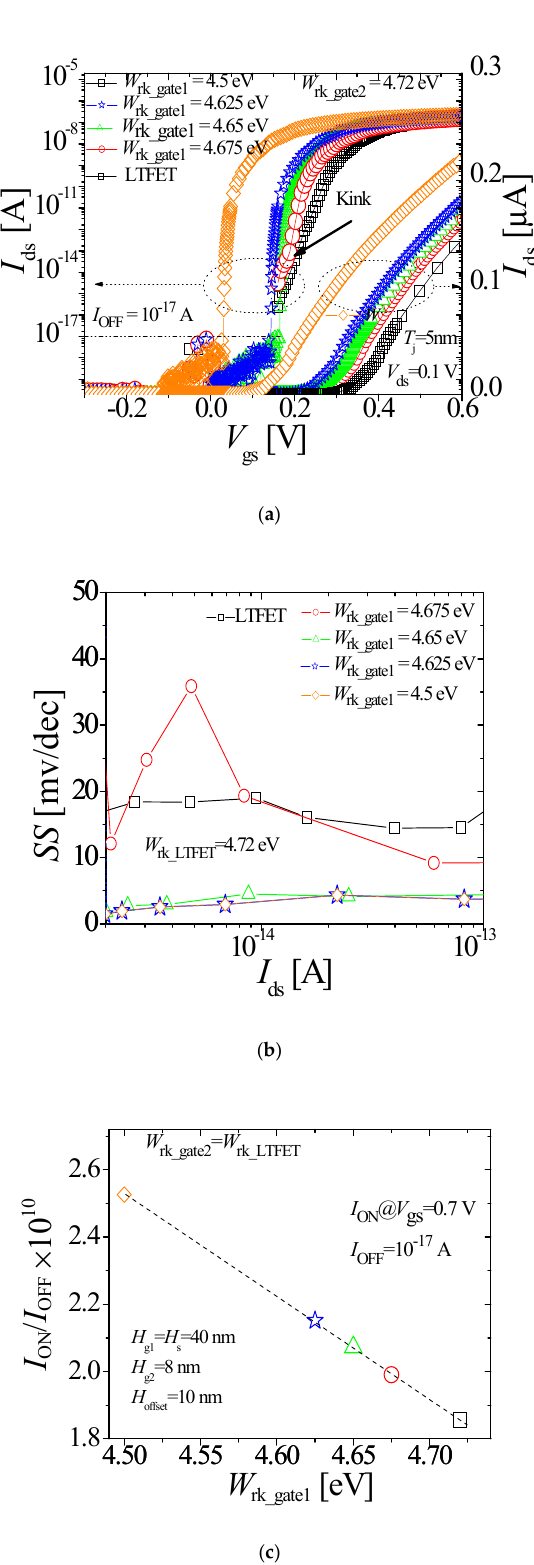
Figure 6. ( a ) I ds - V gs characteristics of DG-LTFET with different W rk_gate1 s and fixed W rk_gate2 = W rk_LTFET . Also shown are I ds - V gs characteristics of the LTFET (black squares). ( b ) SS extracted from I ds - V gs characteristics in Figure 8a. ( c ) I ON / I OFF ratio extracted from I ds - V gs characteristics in Figure 8a. Red circles: W rk_gate1 = 4.675 eV; green triangles: W rk_gate1 = 4.65 eV; blue stars: W rk_gate1 = 4.625 eV; orange diamonds: W rk_gate1 = 4.5